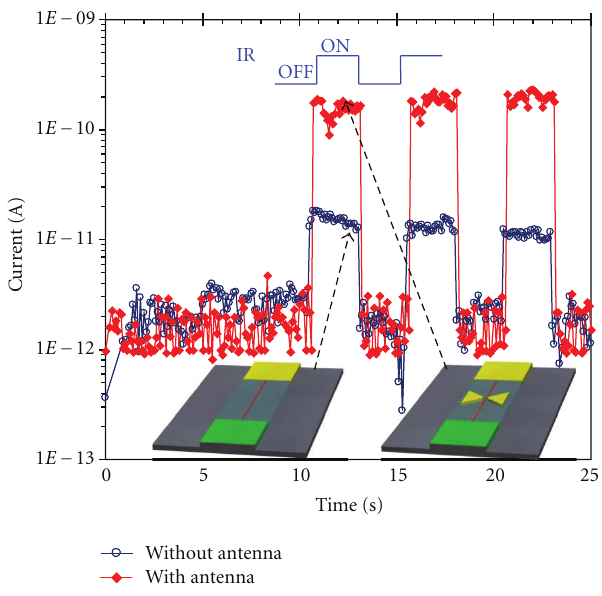
Figure 6: Photoresponses of the CNT photodetector without and with bowtie antenna by switching IR laser on and o ff at